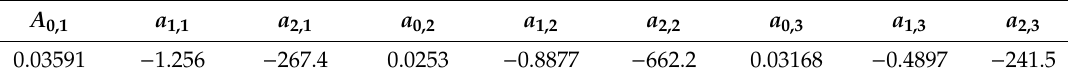
Table 3. Characteristic parameters of the variable speed pumps (VSPs).